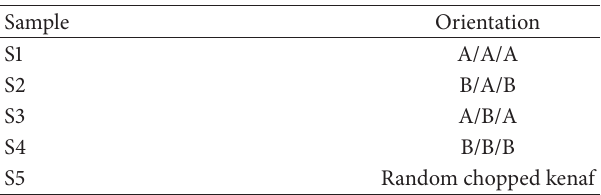
Table 3: List of samples employed at different orientation for mechanical properties